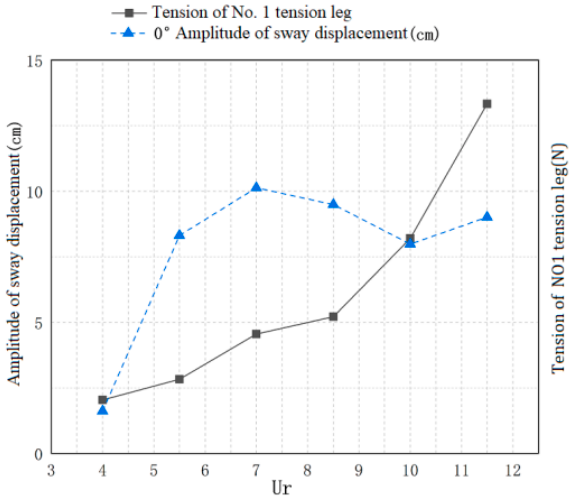
Figure 7. Comparison of tension leg tension amplitude change and sway.